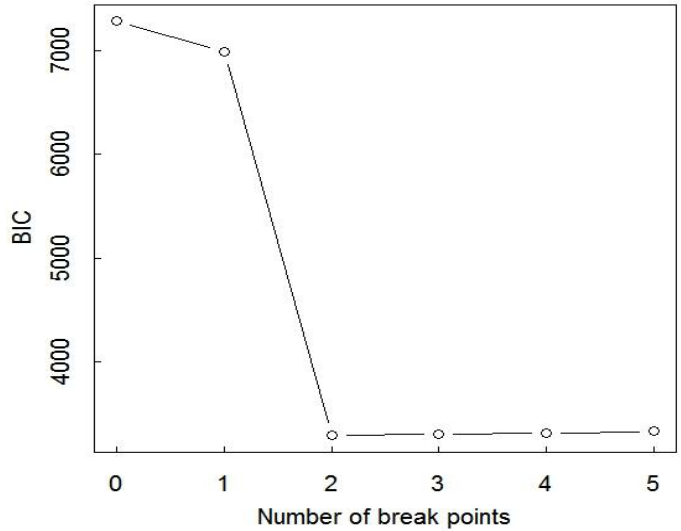
Figure 5. An example of the Bayesian information criterion (BIC) for breakpoints applied to data such as the first tank cycle in Figure 1. The true number of change points is